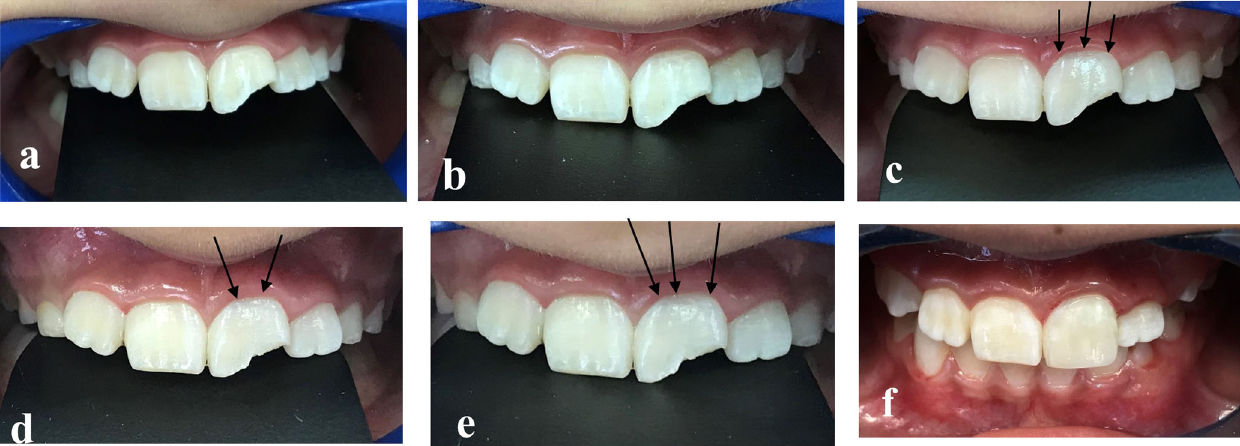
Fig. 5 Clinical photographs of fractured upper left central incisor which was the single case that showed clinical discoloration in Group (N), change in color started to show at the 1 month follow up. a Baseline clinical photograph of upper left central incisor at second appointment, b Clinical photograph at 1 week follow up without discoloration, c Clinical photograph at 1 month follow-up showing shadow of cervical crown discoloration, d Clinical photograph at 3 months follow-up showing cervical crown discoloration, e Clinical photograph at 12 months follow-up showing cervical crown discoloration. f Clinical photograph showing composite